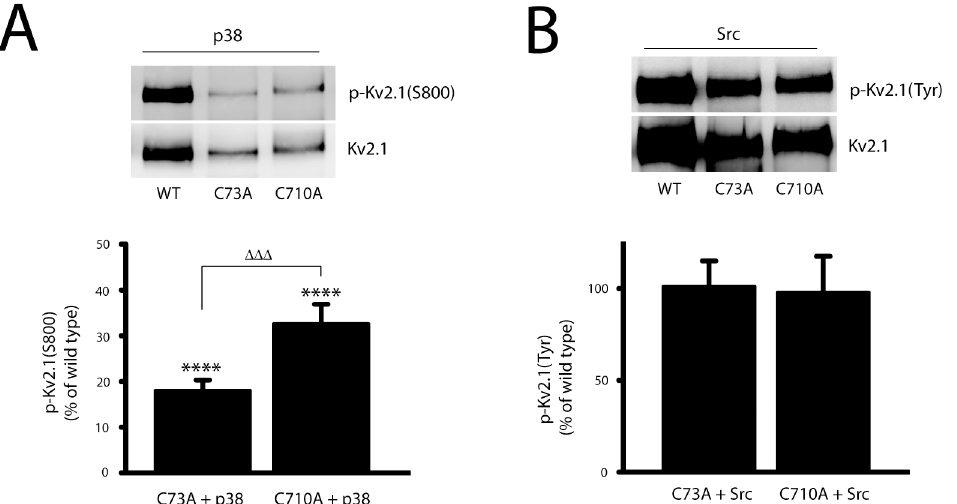
Fig 4. N- and C-terminal cysteine residues differentially influence Kv2.1 phosphorylation. A, CHO cells were co-transfected with plasmid DNAs of p38 (15%), and Kv2.1(WT) (10%), Kv2.1(C73A) (30%), or Kv2.1(C710A) (30%). The membranes with separated immunoprecipitated Kv2.1 protein complexes were co-probed with mouse anti-Kv2.1 monoclonal antibody and rabbit polyclonal antibody specific against serine phosphorylation of Kv2.1 at S800, p-Kv2.1 (S800). The level of p-Kv2.1(S800) was calculated from the ratio of p-Kv2.1(S800) to total Kv2.1 protein, and then normalized to the level of p-Kv2.1(S800, WT) in p38-transfected CHO cells. The values represent mean ± SEM from 7 independent experiments ( **** p < 0.0001, compared with Kv2.1WT; one sample, two-tailed t test; and ΔΔΔ p < 0.001, two-tailed paired t test). B, CHO cells were co-transfected with plasmid DNAs of Src (15%), and Kv2.1 (WT, 10%), Kv2.1(C73A, 30%), or Kv2.1(C710A, 30%). Immunoblot was co-probed with rabbit anti-Kv2.1 polyclonal antibody (Kv2.1) and mouse anti-phosphotyrosine antibody, p-Kv2.1(Tyr). The signal densities of p-Kv2.1(Tyr) and total Kv2.1 proteins from Kv2.1WT, Kv2.1(C73A) and Kv2.1(C710A) were quantified as described above. The level of p-Kv2.1(Tyr) was calculated as the ratio of pKv2.1(Tyr) to total Kv2.1 protein and normalized to tyrosine phosphorylation of Kv2.1WT in CHO cells with Src overexpression. Similar p-Kv2.1(Tyr) levels were detected in Src-expressing CHO cells in WT, C73A and C710A groups.